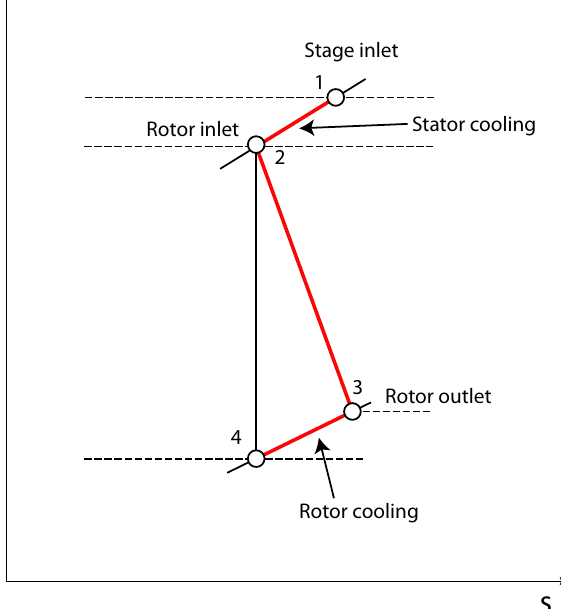
Figure 4. Specific enthalpy–specific entropy diagram of the applied expansion model in a cooled turbine stage after [25,26].